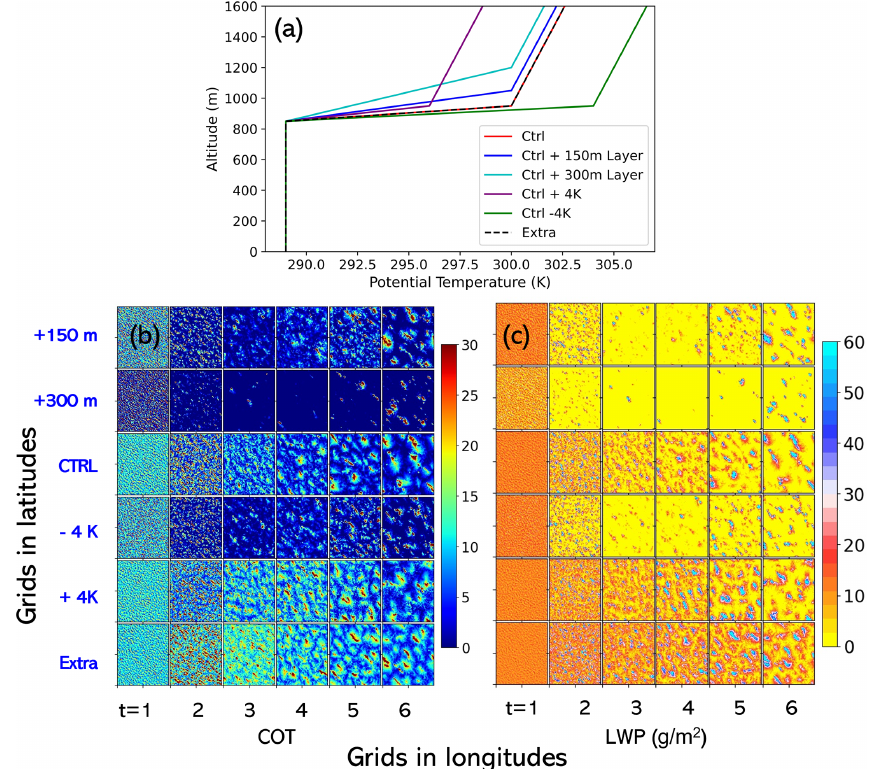
Figure 2. Panel (a) the initial potential temperature profiles for the five cases of stratocumulus simulations: “Control”, “Control + layer 150m”, “Control + layer 300m”, “Control – 4K”, “Control + 4K”, and “Extra” (described in Sect. 2.1); (b) the spatial distribution of cloud optical thickness for the six cases for each 30min time steps; (c) as in (b) but for the rainwater path, the cloud boundary is determined by the condensation of cloud droplets > 20mg − 1